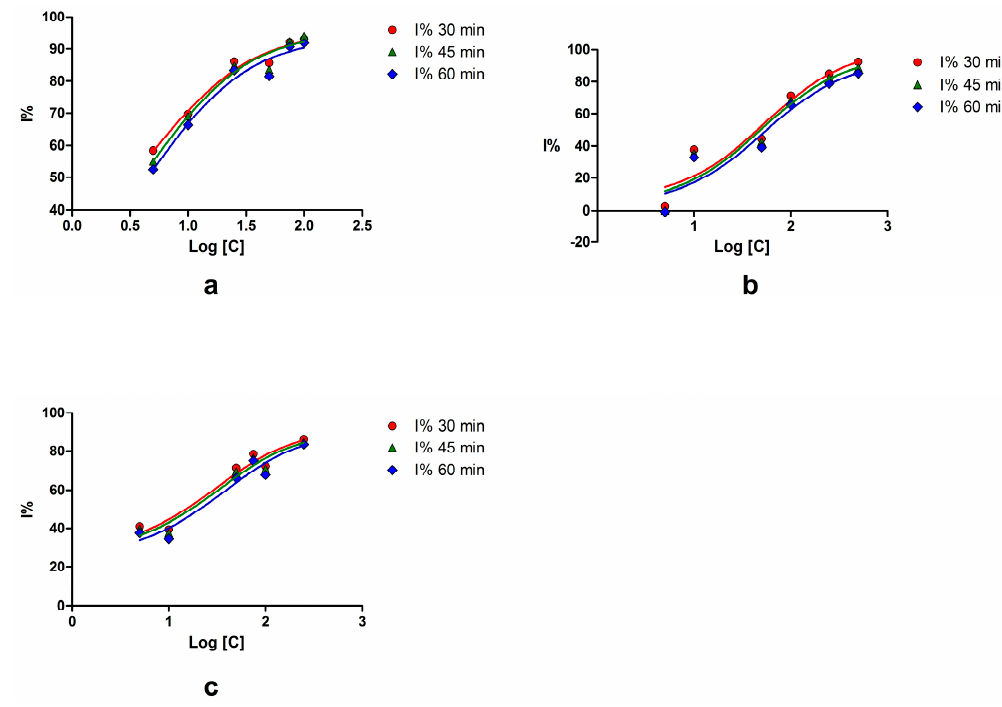
Figure 1. The inhibitory effect of natural compounds on SrtA after 30, 45, and 60 min. ( a ) myricetin; ( b ) palmatine chloride; ( c ) esculetin.